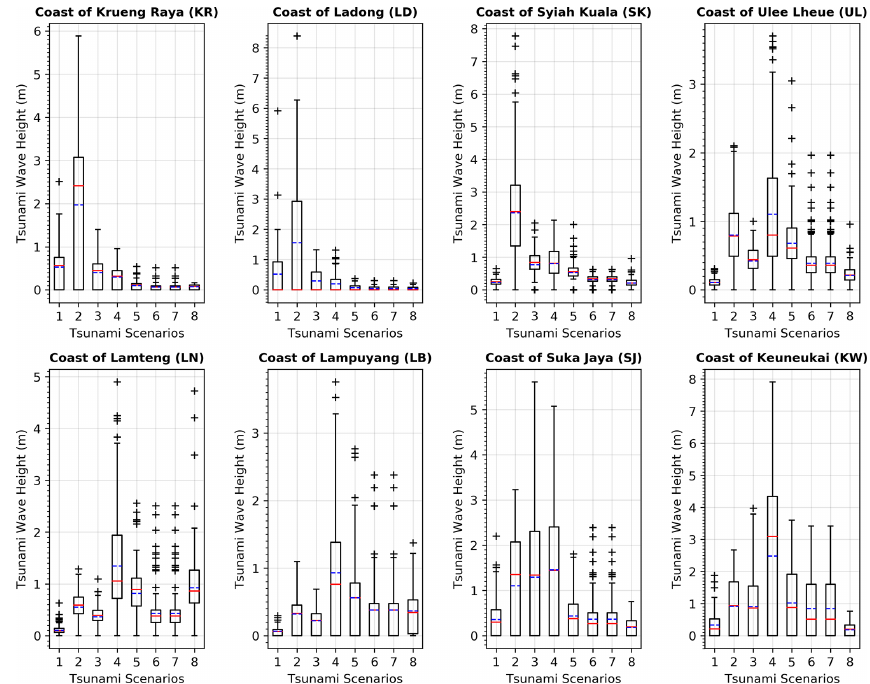
Figure 10. Box and whisker plots (Massart et al., 2005) of the maximum tsunami wave amplitude along the selected coastlines of Fig. 6c. The “ + ” sign indicates the extreme values, while the solid red and dashed blue lines indicate the median and mean, respectively. The title of each plot indicates the cross-section location, the x axis is shown for the landslide scenarios indicated in Table 2, while the y axis indicates the tsunami wave height shown in